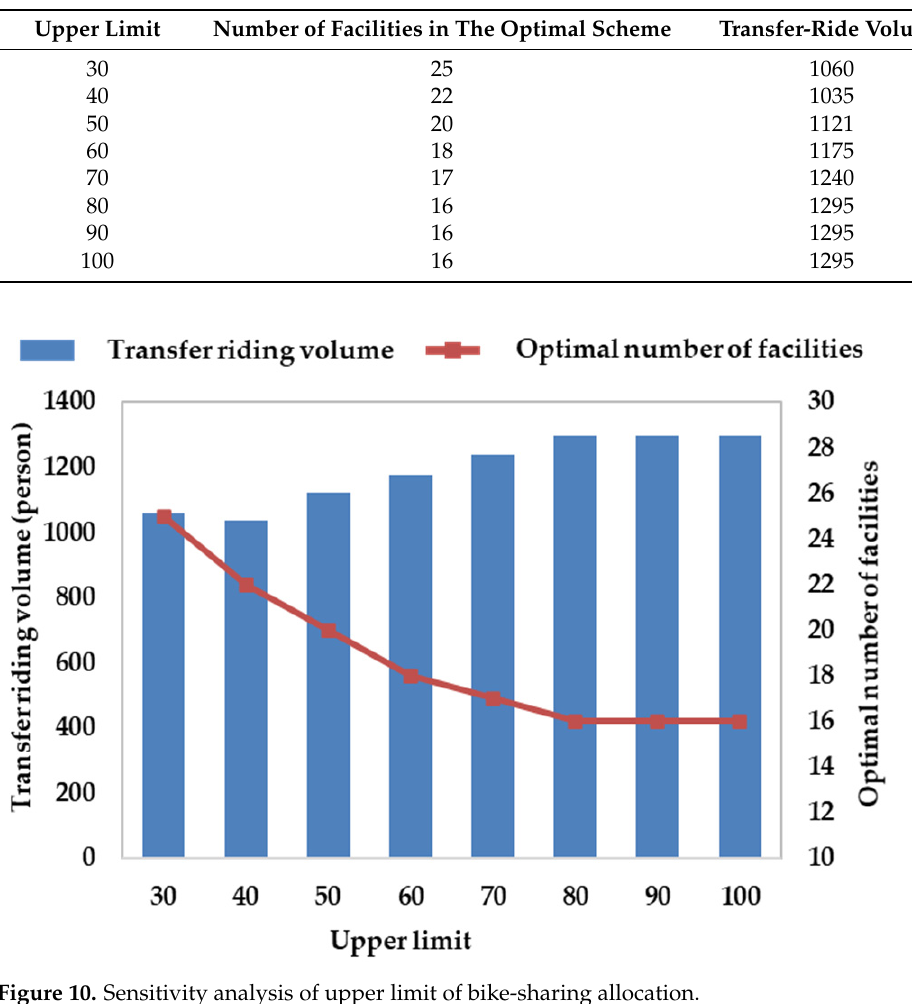
Table 7. Change of optimal layout scheme with the upper limit.